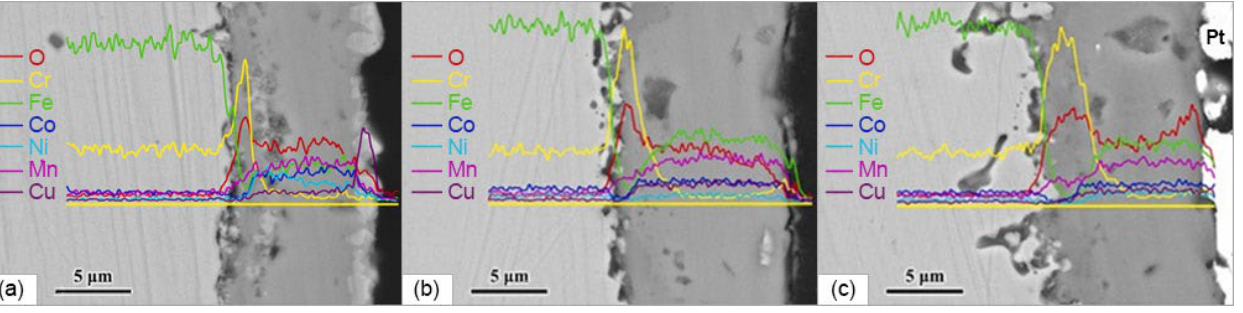
Figure 6. Cross-sectional images of the FeCoNiMnCu (1:1:1:1:1:1) HEA coating on SUS 430 steel after thermal treatment at 800 °C in air: ( a ) 1 week; ( b ) 5 week; ( c ) 10 weeks (reproduced from [19] with the permission of Elsevier).